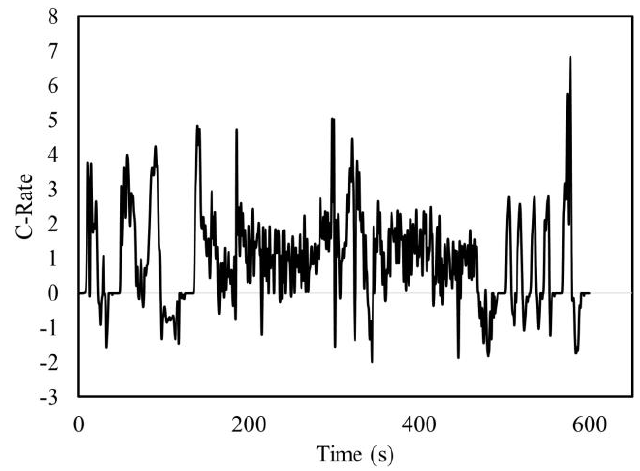
Figure 11. Current profile for a US-06 drive cycle simulated in Autonomie.